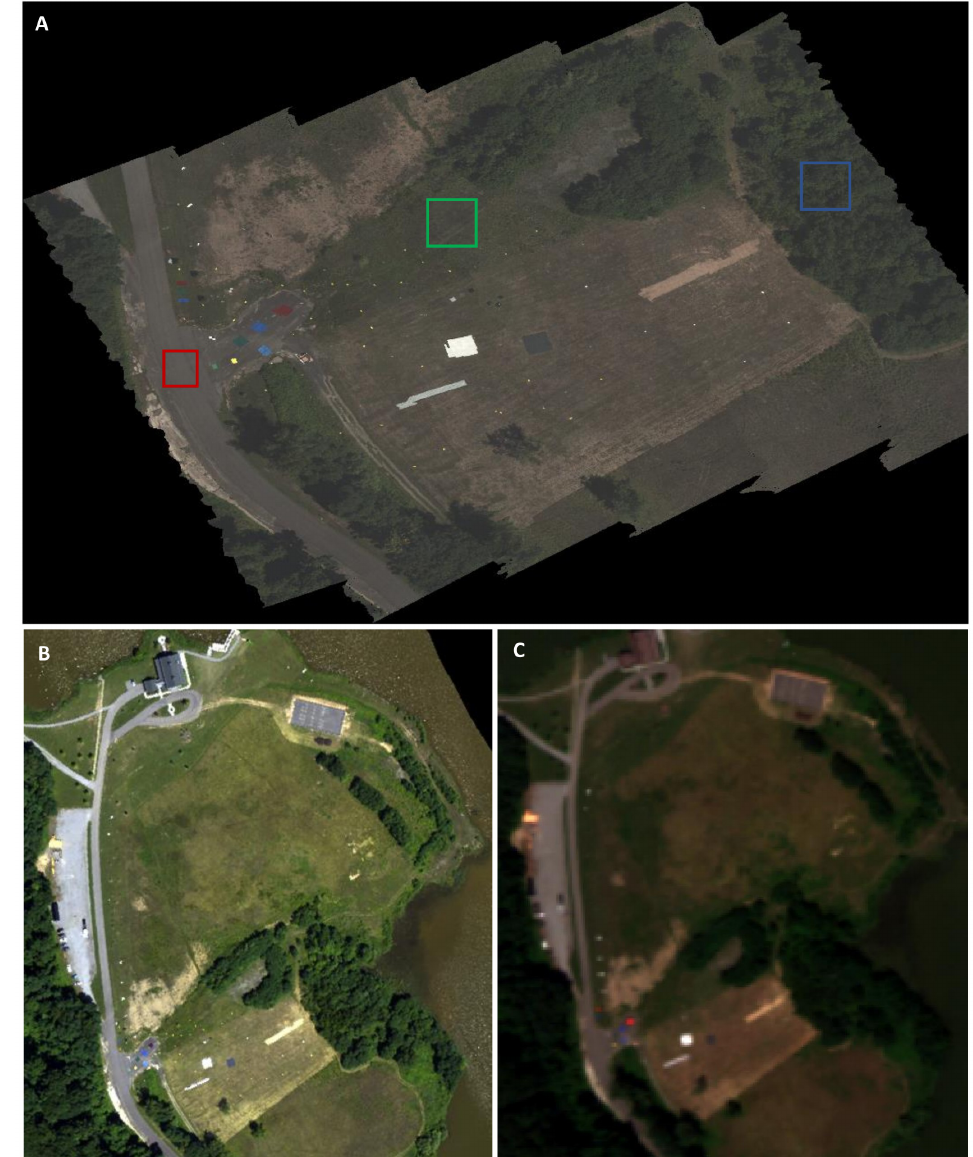
Figure 7. Example imagery of the Tait Preserve and primary target area from UAV MX-1 VNIR over- pass mosaic ( A ), airborne CASI ( B ), and satellite WorldView-2 ( C ). Red, green, and blue highlighted areas in the UAV image were used in comparison of surface reflectance retrievals across all